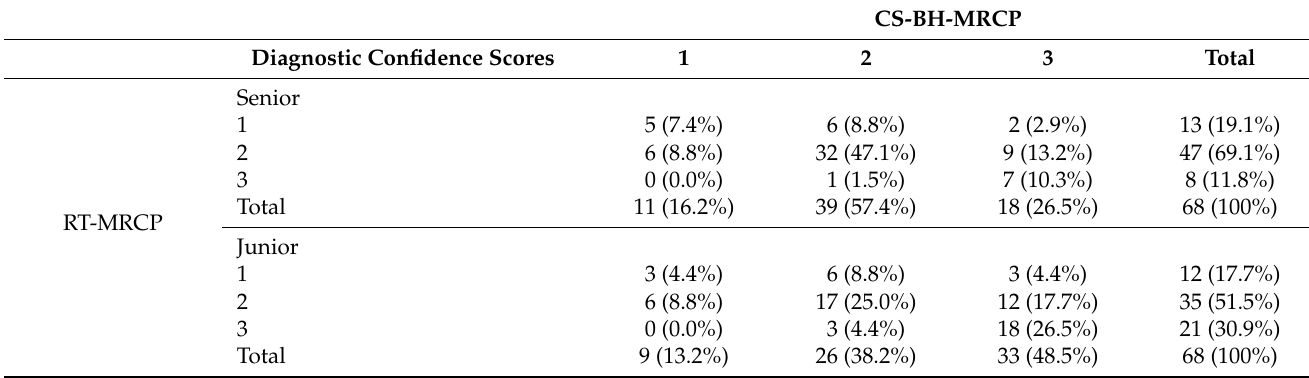
Table 7. Cross-tabulation analyses: diagnostics confidence scores with CS-BH-MRCP versus RT-MRCP sequences for senior and junior